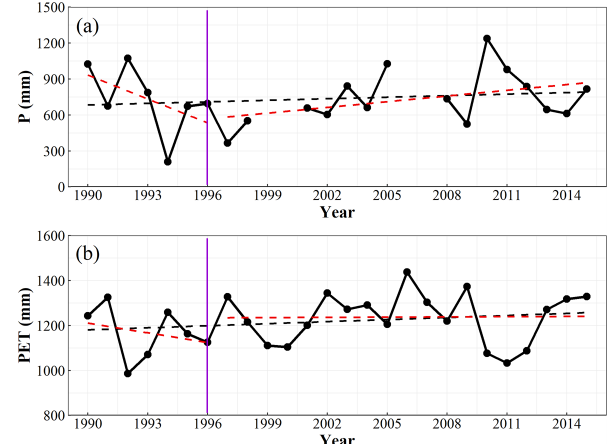
Figure 7. Changes in (a) annual rainfall ( P ) and (b) annual poten- tial evapotranspiration (PET) of the Kileys Run catchment (control catchment) during the period of